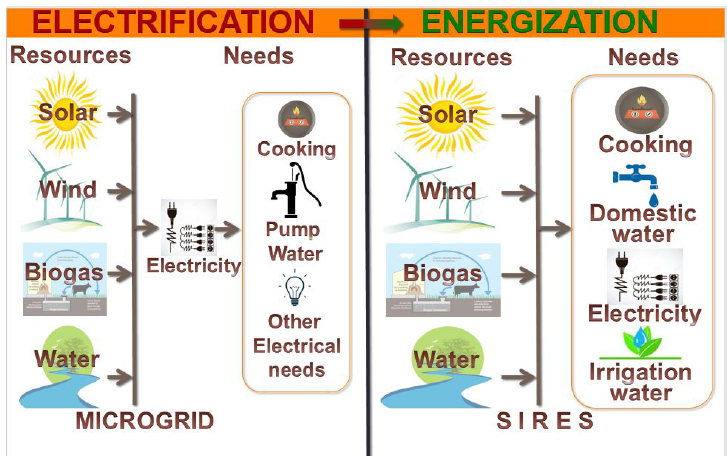
Figure 1. Electrification vs.